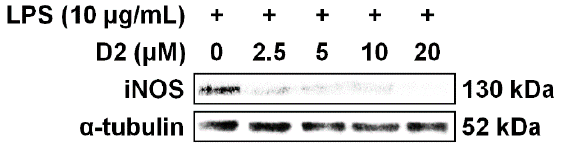
Figure 4. Concentration-dependent inhibitory effects of the 2-amino-4-picoline (D2) derivative of Monascus pigment on expression of inducible nitric oxide synthase (iNOS) in Raw 264.7 cells stimulated with lipopolysaccharide (LPS).